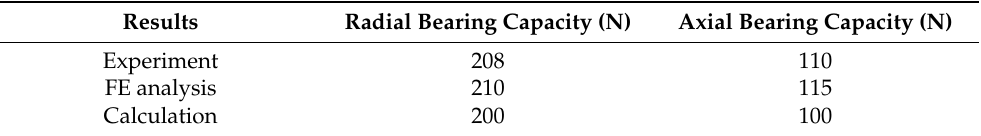
Table 3. Comparison of experiment results, FE analysis results and calculation